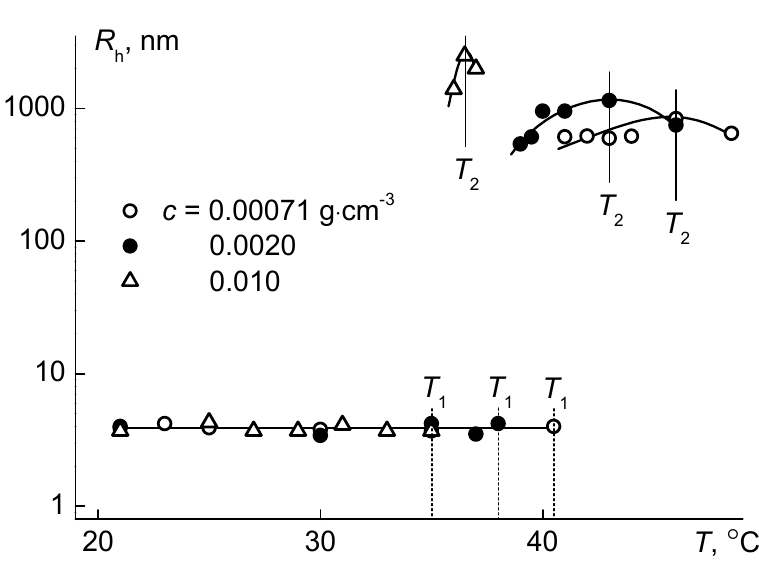
Figure 9. Dependences of hydrodynamic radii R h of scattering species on temperature T for aqueous solutions of PiPrOx-m.